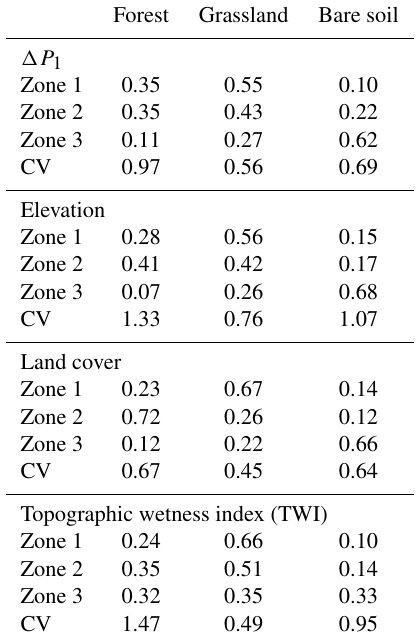
Table 2. Average values of the hillslope ratio of forests, grasslands, and bare soil for each zone and